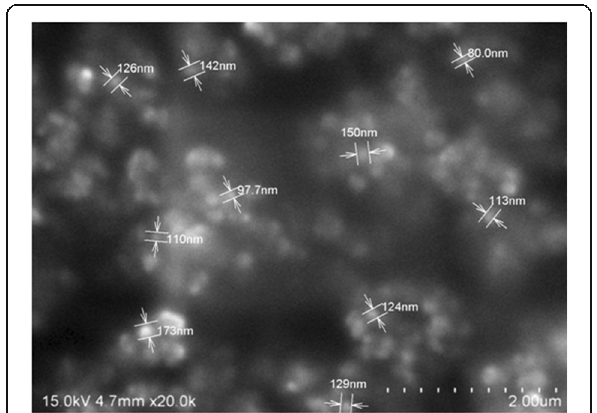
Fig. 7 SEM image exhibiting morphology and particle